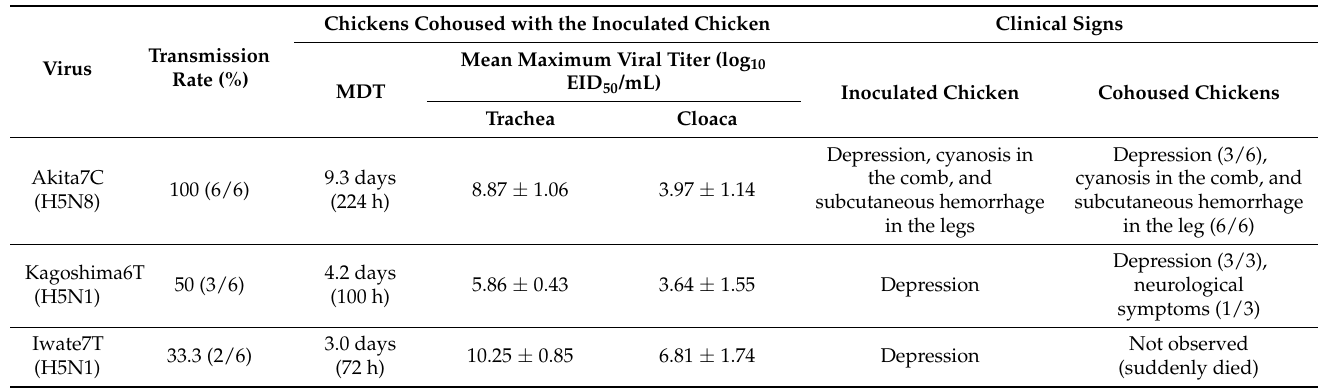
Table 2. Transmission rate, mean death time, mean maximum viral titer, and clinical signs.